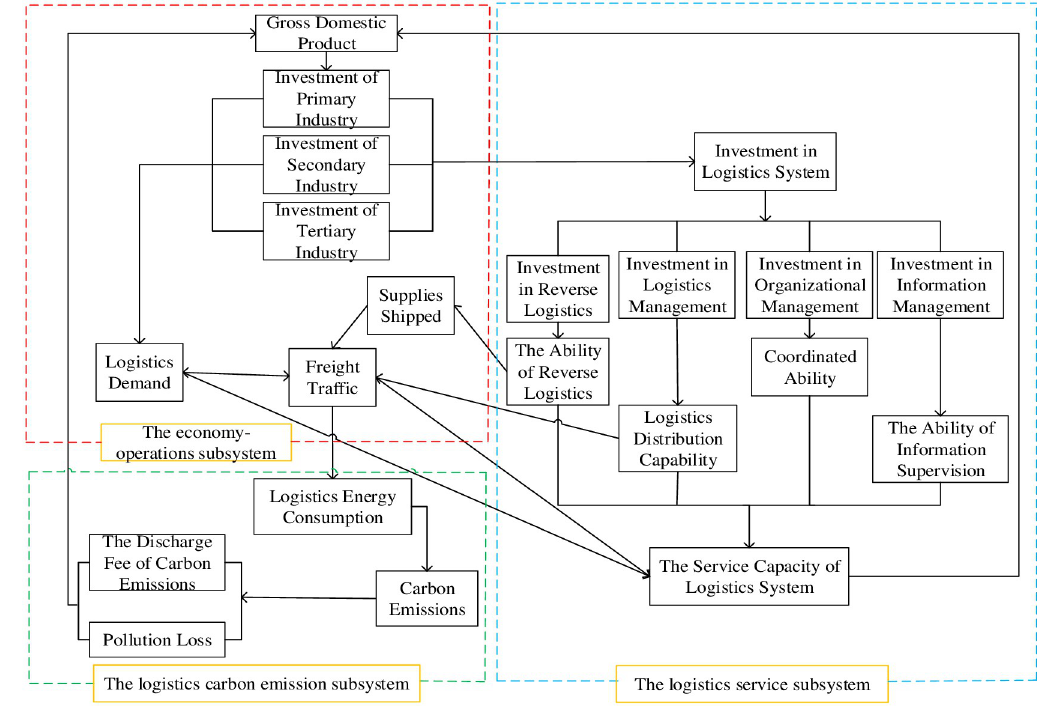
Fig 1. Functional relationship of major subsystems. Source: Authors’ own